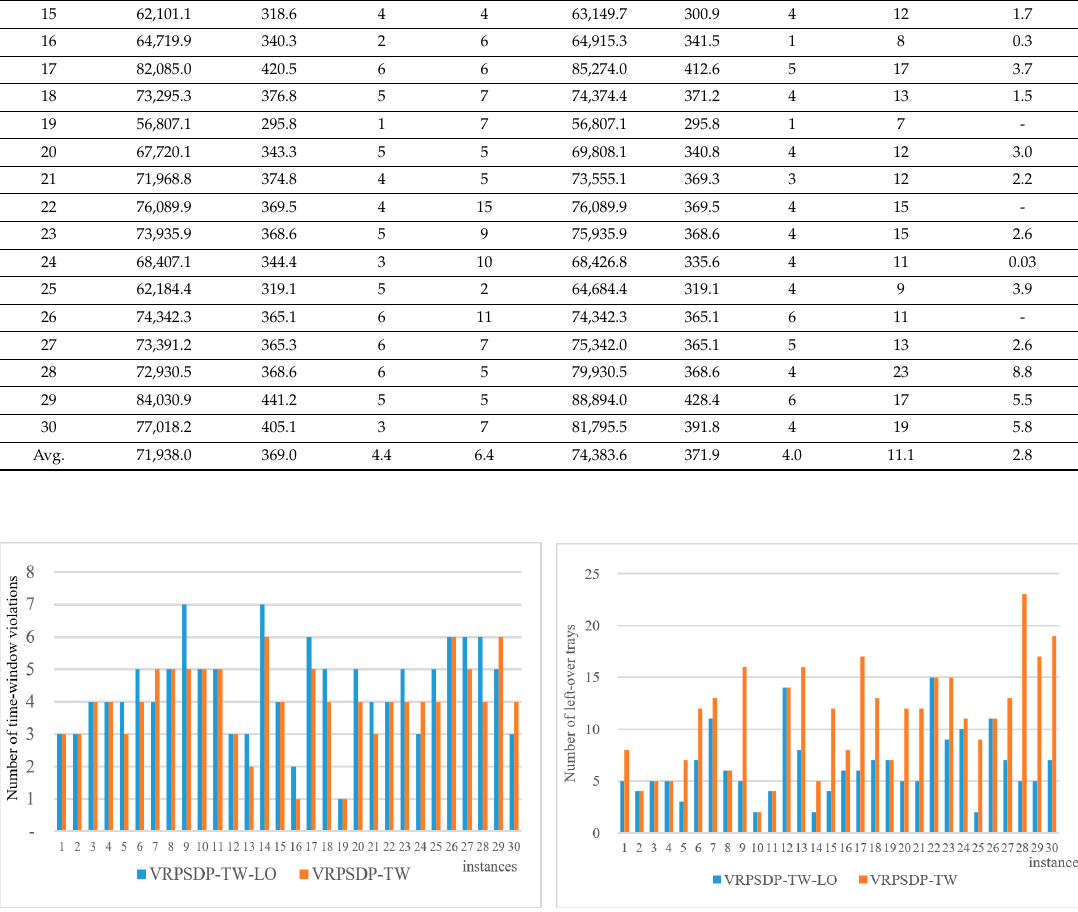
Figure 2. Difference of performance between vehicle routing problem with simultaneous delivery and pick-up under a time window, VRPSDP-TW, and considering left over cost, VRPSDP-TW-LO. Generally, the total travelling distance of the VRPSDP-TW-LO model was longer than the VRPSDP-TW model, because the dotted line was located under the zero. Also, it is possible to see that the number of time-window violations is bigger than for the VRPSDP-TW. However, the total number of left-over trays is lower than for the VRPSDP-TW because it is included in the objective function. In order to secure the statistical validity, a paired t -test was conducted, which showed a statistically significant difference in the total cost between VRPSDP-TW and VRPSDP-TW-LO. Table 3 shows the pair mean differences for instances and p value. The mean difference of VRPSDP-TW and VRPSDP-TW-LO was -2,445.7, with a p value of 0.014. This indicates that VRPSDP-TW-LO is statistically significantly different and can show better solutions.